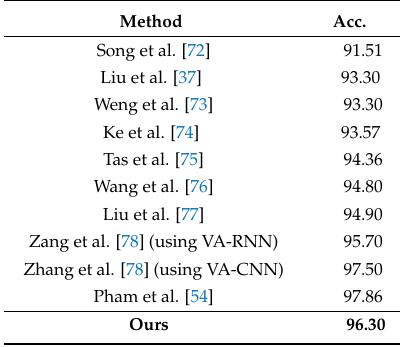
Table 3. Test accuracies (%) on the SBU Kinect Interaction dataset [20]. Please note that many previous methods are based on depth